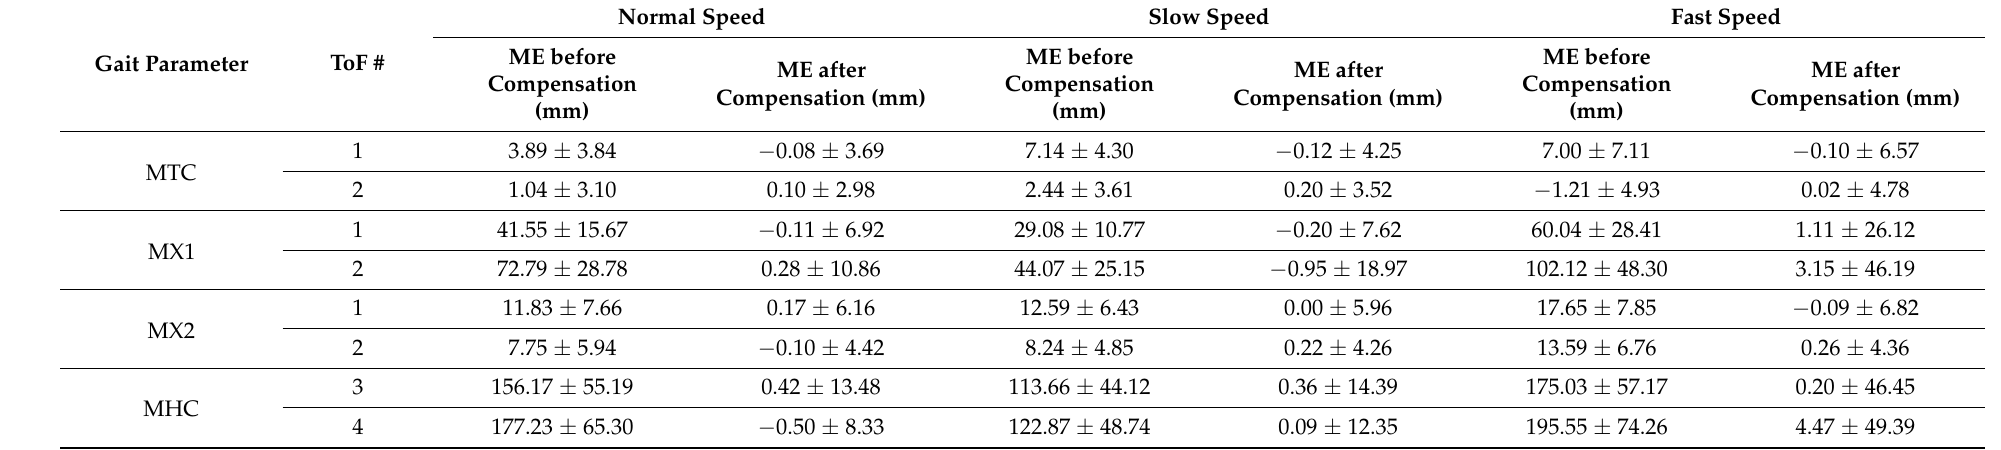
Table 5. The ME results of the proposed wearable system before and after angle and offset compensation for each gait parameter, ToF sensor, and walking speed.